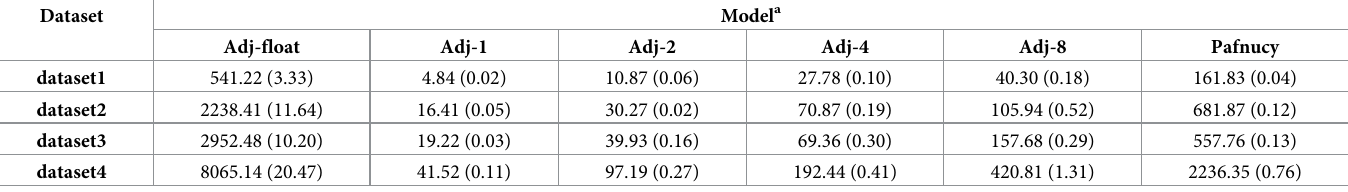
Table 7. The training time of the models with the PDBbind 2016 database.